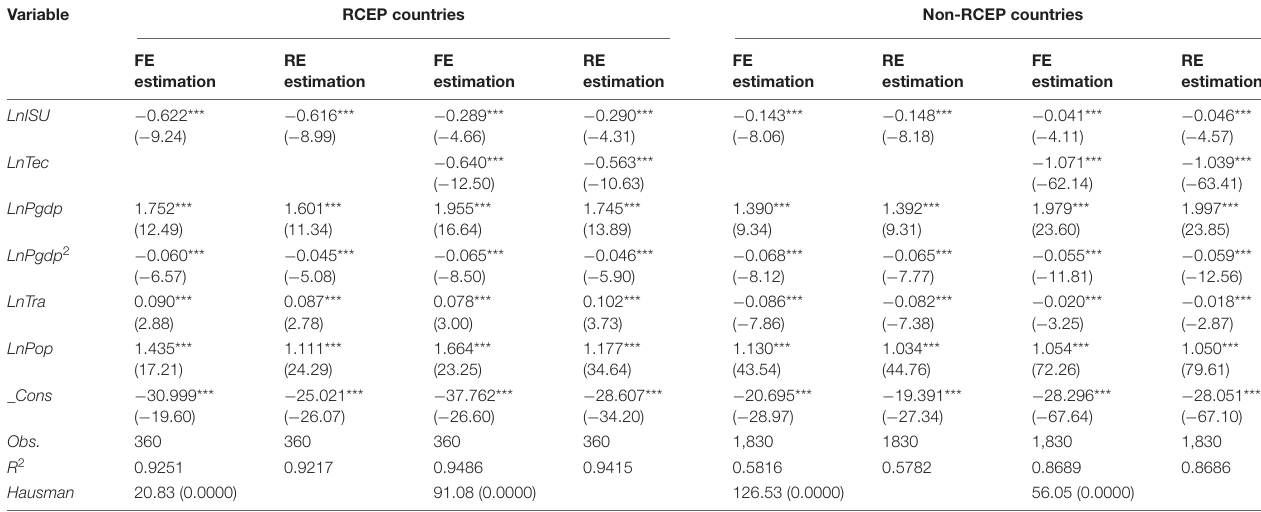
TABLE 6 | Results of the FE and RE estimates across RCEP and non-RCEP countries. Variable RCEP